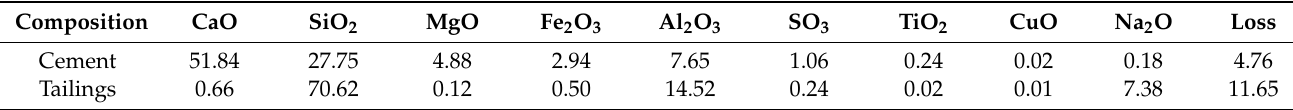
Table 1. Chemical composition of cement and tailings.